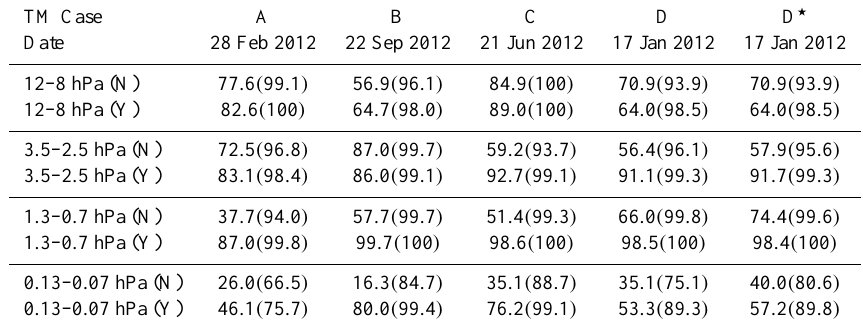
Table 2. The percentage of coincident domains in which the H 2 O from TM and Aura MLS observations agree within 10 (20 ) % in each pressure layer. All four studied TM scenarios (A–D) with applied bias correction (Y), according to Sect. 2.2, or no correction (N) are shown. In the last column the percentages regarding the ECMWF sensitivity case study D (cid:63) (30 % downscaled mesospheric wind velocities for TM) are given. TM Case